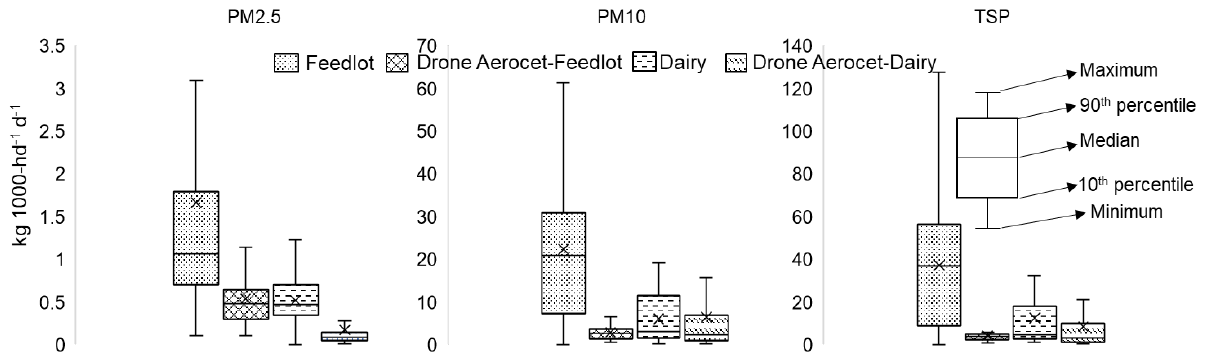
Figure 7. Overall collocated samplers emission factor (kg 1000-hd − 1 d − 1 ) throughout the sampling period.